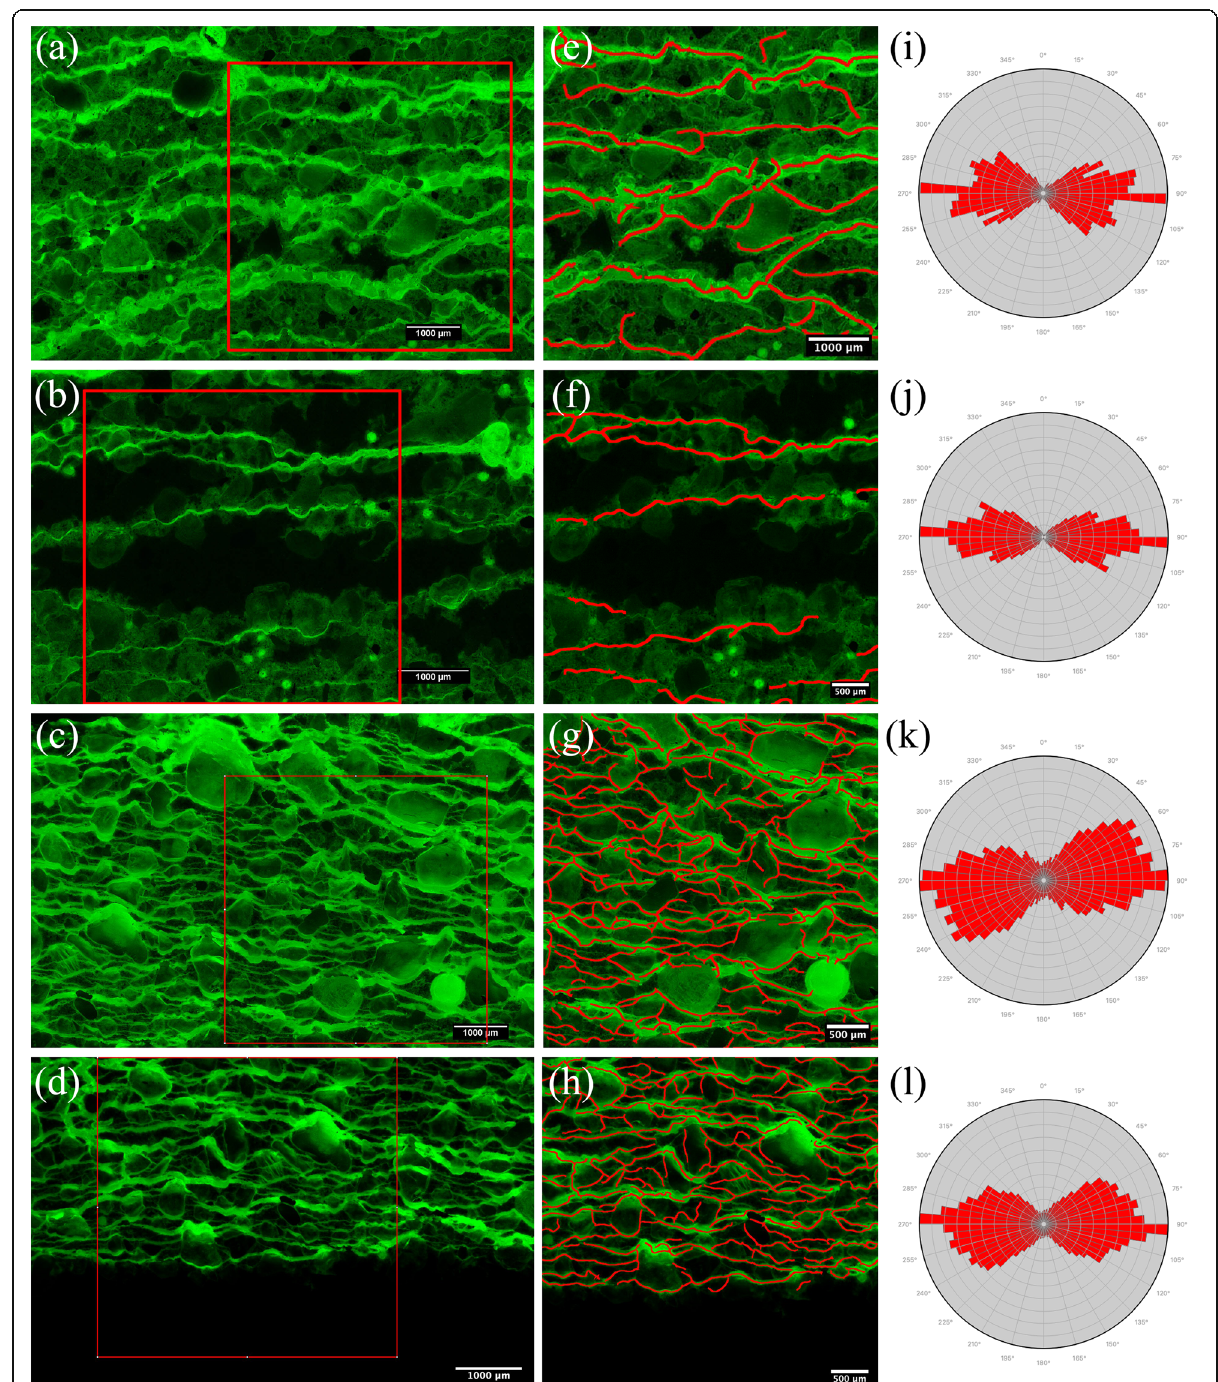
Fig. 5 a and b Fluorescent reflected light photomicrographs (FRLP) of the polished surface of the damaged field mortar showing cracks/ microcracks in the upper and lower zones from the top surface, respectively. c and d FRLP of the polished surface of the lab-cast mortar showing cracks/microcracks in the closer (outward) and further (inward) zones from the outer surface, respectively. e - h Identified crack network in the red zone in ( a - d ). i - l Rose diagrams showing the cracking orientation in ( e - h